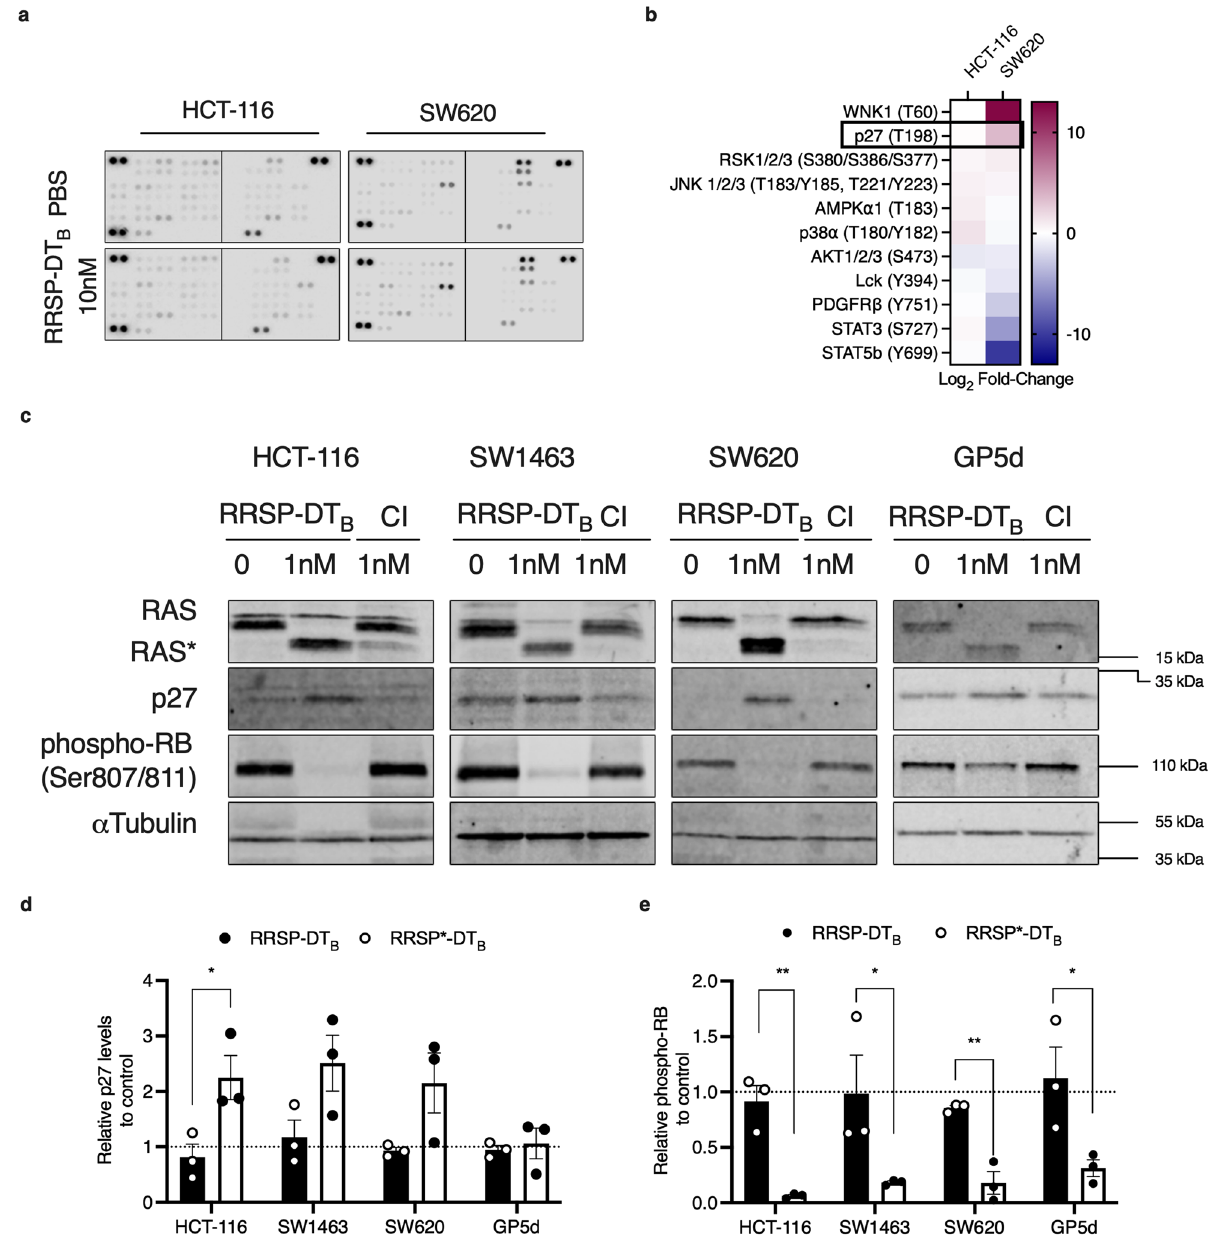
Figure 4. RRSP-DT B cleavage of RAS induces p27 expression in CRC cell lines. ( A ) Human phospho- kinase array blots of HCT-116 and SW620 cells treated with either PBS or RRSP-DT B (10 nM) for 24 h. ( B ) Densitometric analysis kinase array depicted through a heatmap of relative phosphorylated proteins levels in response to RRSP-DT B compared to PBS control in HCT-116 and SW620 cells, n = 1. ( C ) Representative western blot images of p27 and phosphor-RB expression in CRC cell lines treated with either RRSP-DT B or RRSP*-DT B for 24 h. Protein detection for each immunoblot was conducted on the same blot and cropped for each individual protein of interest. Full length blots can be found in Supplementary Fig. 9. ( D,E) Densitometric analysis of fold change in p27 and phospho-RB compared to PBS after 24 h in RRSP-DT B treated CRC cell lines; n = 3. αTubulin was used as gel loading control. Results are expressed as mean ± SEM of three independent experiments (* P < 0.05, ** < 0.01, **** < 0.0001 versus PBS control as determined through one-way ANOVA followed by Dunnett’s multiple comparison